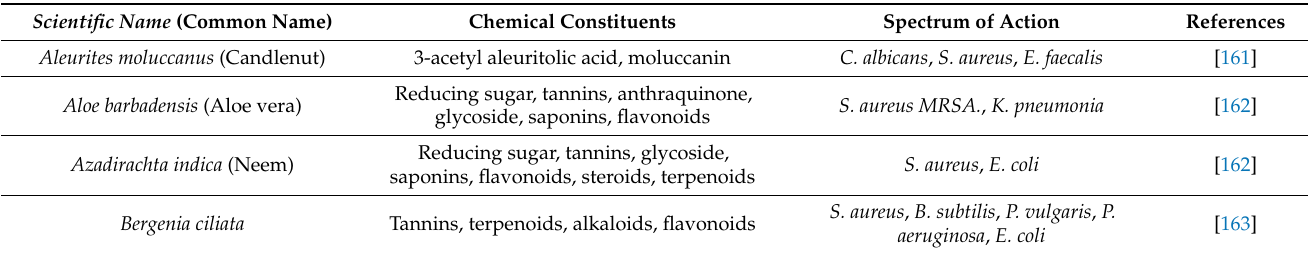
Table 2. Plants with antimicrobial